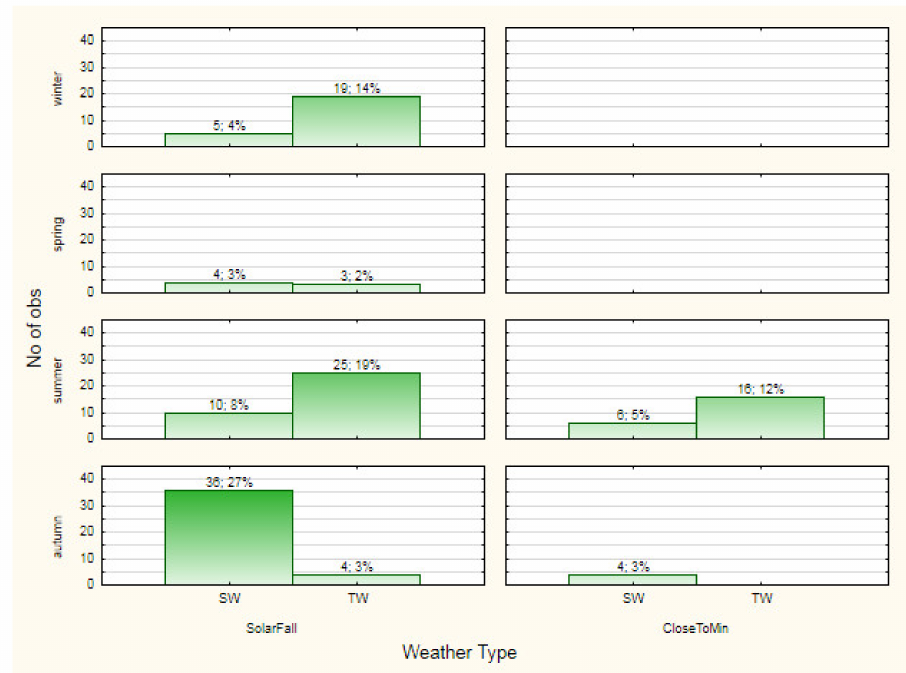
Figure 9. The distribution of the ratio between Space Weather (SW) and Terrestrial Weather (TW) characteristics, which differ when they correspond to the different medical events, by the phases of a solar activity cycle and calendar seasons, and they were common for the both gender